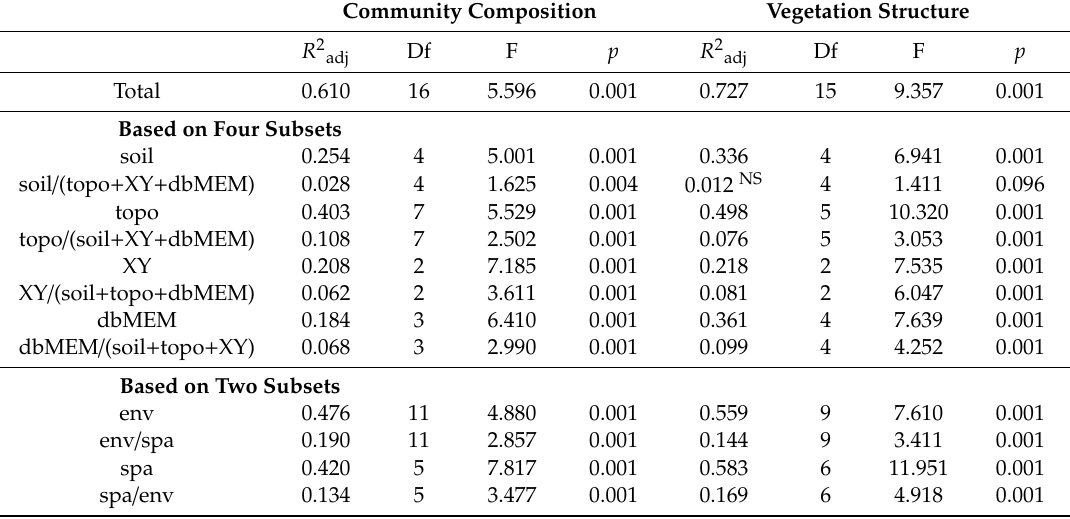
Table2. Resultsofredundancyanalysis(RDA)andvariationpartitioningofcommunitycompositionand vegetation structure based on two and four explanatory subsets. (topo, topography; env, environmental process; spa, spatial process; XY, geographic coordinates; dbMEM, dbMEM